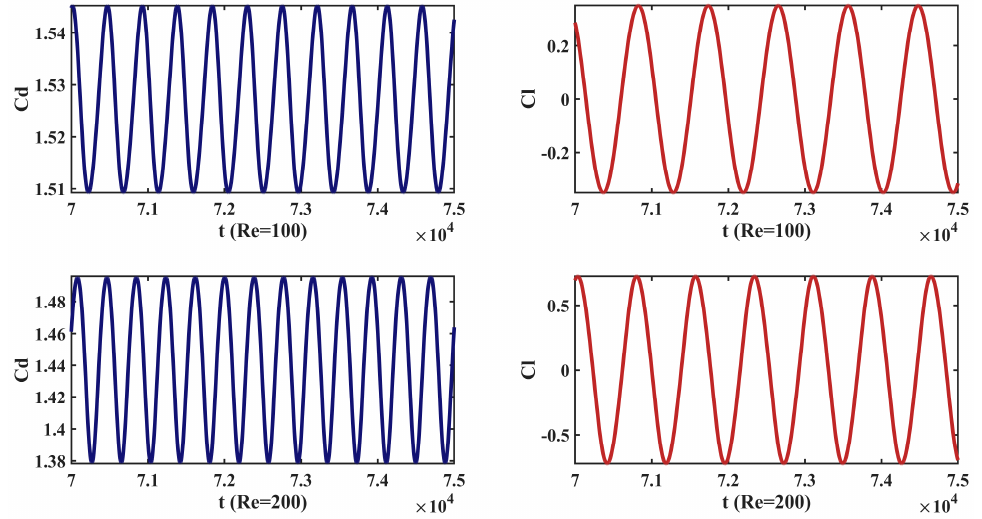
Figure 5. Drag coefficient curve and lift coefficient curve when Re = 100 and 200.